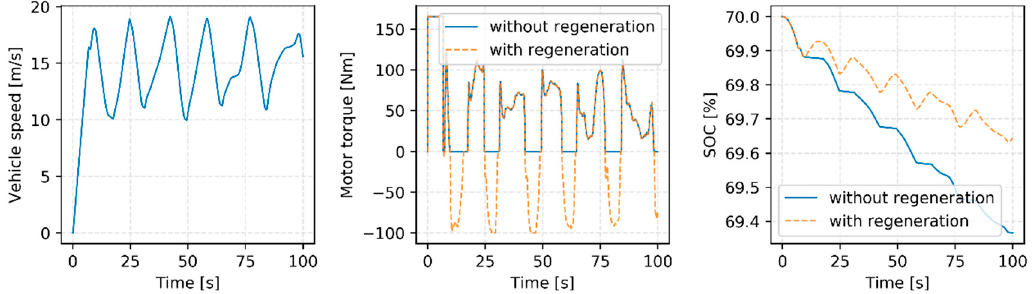
Figure 5. Regenerative control of the vehicle model.